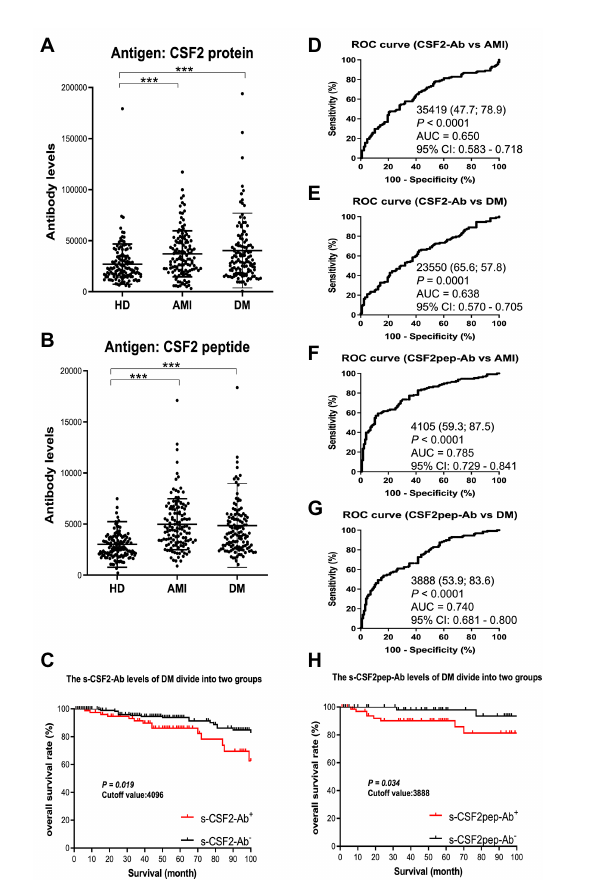
FIGURE 3 Comparison of the s-CSF2-Ab and s-CSF2pep-Ab levels between HDs and patients with AMI and DM. ( A,B ) The levels of s-CSF2-Ab and s-CSF2pep-Ab in HDs and patients with acute myocardial infarction (AMI) ( A ) and diabetes mellitus (DM) ( B ) were determined using AlphaLISA. The bars represent averages ± SD. *** P < 0.001, Mann–Whitney U test. ( D,E ) The ROC curves to assess the ability of s-CSF2-Ab to predict AMI and DM are presented in ( D ) and ( E ), respectively. ( F,G ) The ability of s-CSF2pep-Ab to predict AMI ( E ) and DM ( F ) was also evaluated via ROC analysis. Comparison of the overall survival in patients with DM between the s-CSF2-Ab positive (s-CSF2-Ab + ) and s-CSF2-Ab negative (s-CSF2- Ab − ) groups ( P = 0.019; C ) and between the s-CSF2pep-Ab